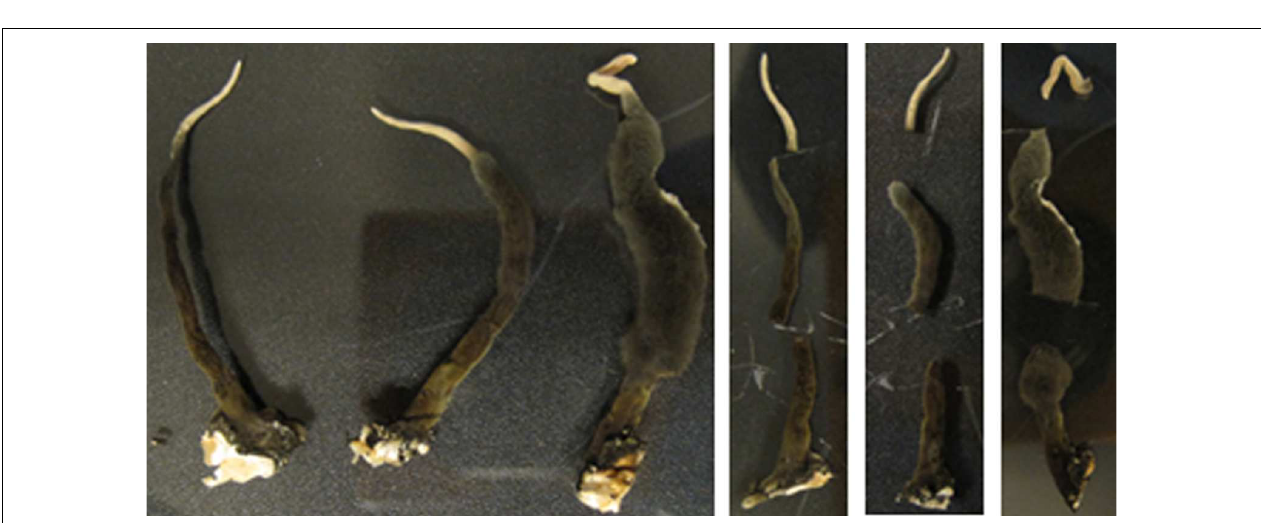
FIGURE 2 | Images of G536 grown in a glass Petri dish and placed in a sterile plant tissue-cultivating container (Plant Con R (cid:13) ) to maintain sterile conditions while providing room for stroma growth.